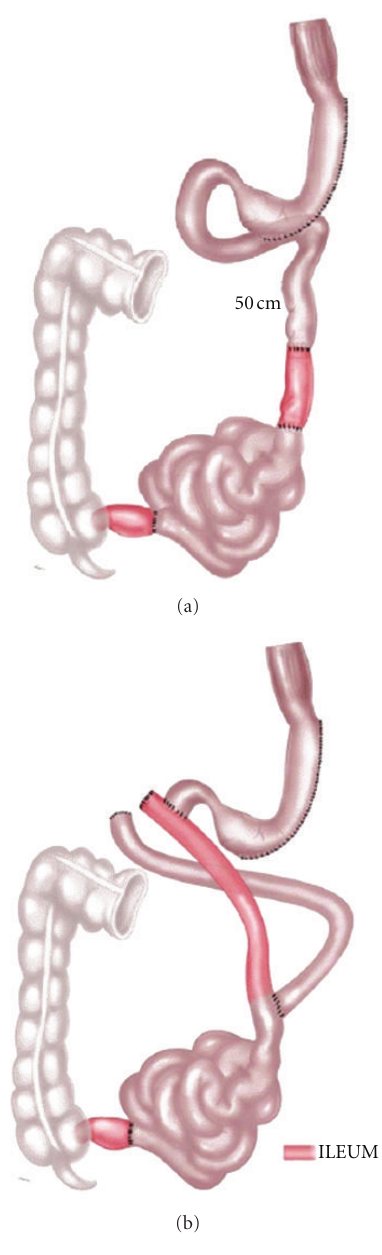
Figure 5: (a) Ileal interposition associated to sleeve gastrectomy. (b) Ileal interposition associated to diverted sleeve gastrectomy.